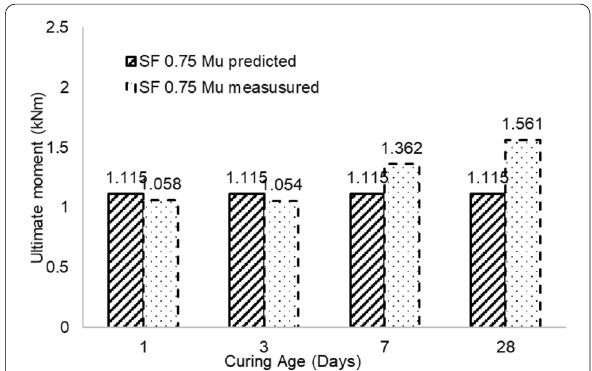
Fig. 8 Comparison between predicted and measured ultimate moment capacity at each measured date-0.75%SFRC